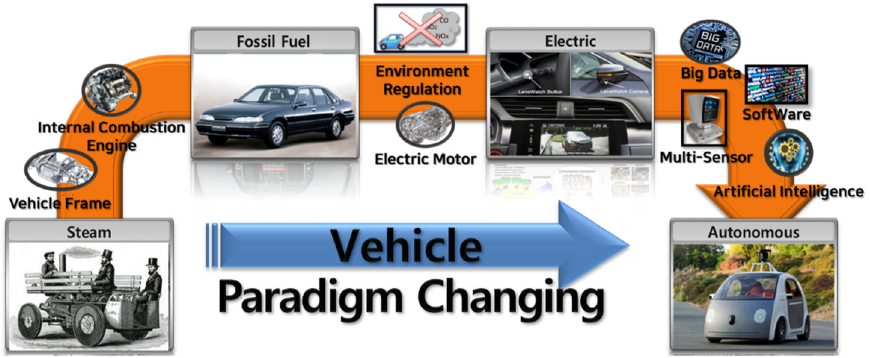
Figure 2. Paradigm change for vehicles (steam to autonomous).